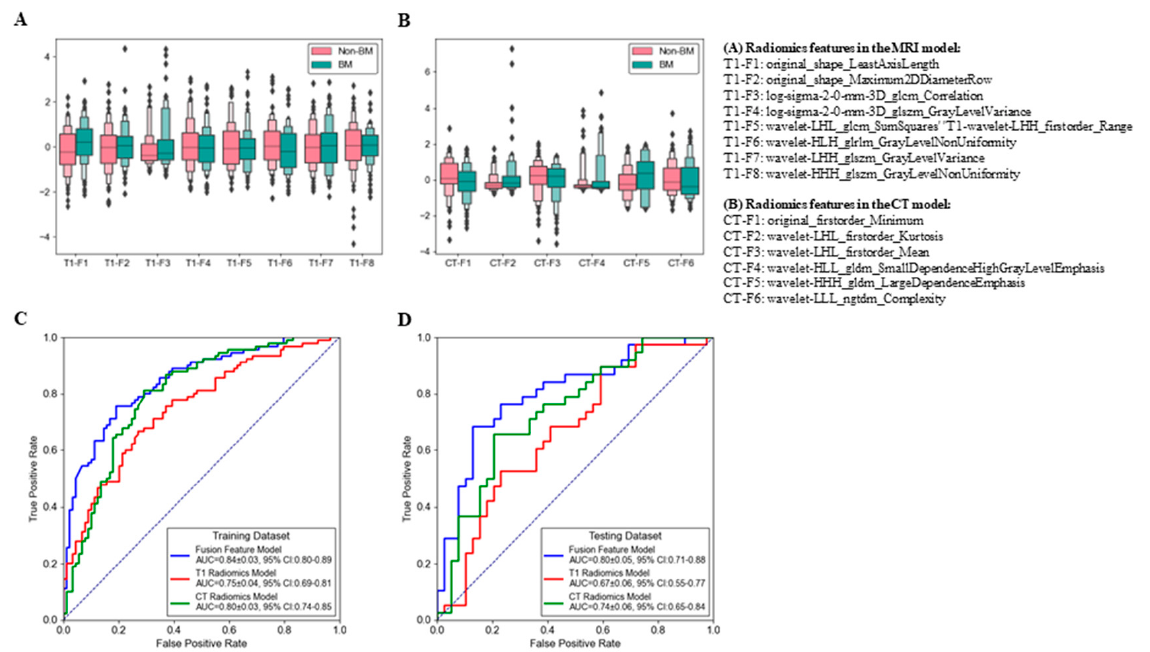
Figure 2. Radiomic features and brain metastasis prediction efficacy of the radiomic models. ( A,B ) Boxplots of the selected radiomic features in ( A ) the brain MRI model, ( B ) chest CT model. ( C,D ) Receiver operating characteristic curves of the radiomic prediction model in the training ( C ) and testing ( D ) datasets. Table 2. Brain metastasis prediction efficacy of the radiomic models.